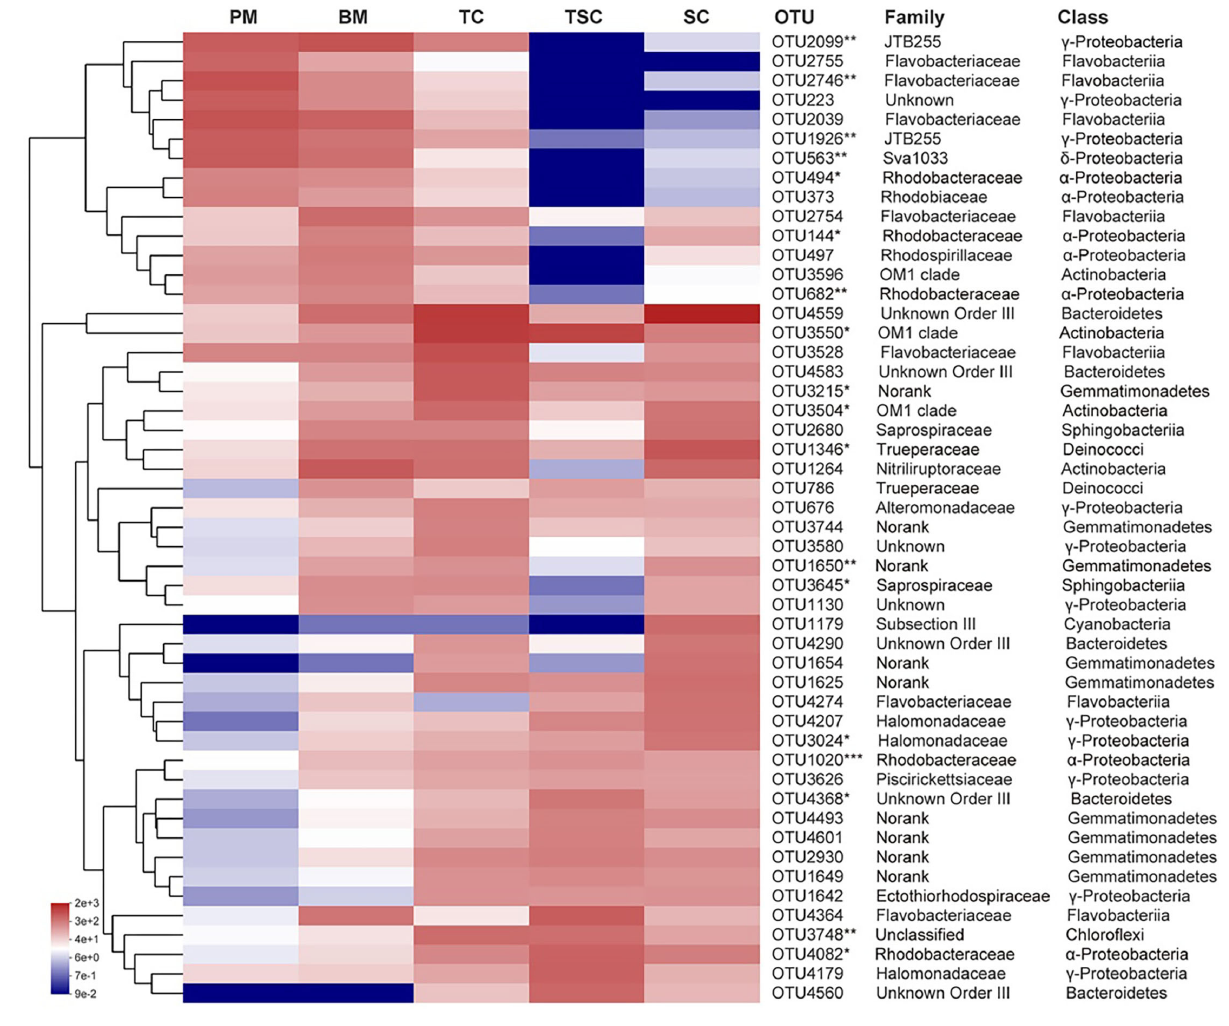
FIGURE 4 | The relative abundances of top 50 OTUs at the family and class levels in the five habitats. The symbol (*) indicates the significantly different bacteria. The * symbol indicates the value of p < 0.05, the ** symbol indicates the value of p < 0.01, and the *** symbol indicates the value of p <